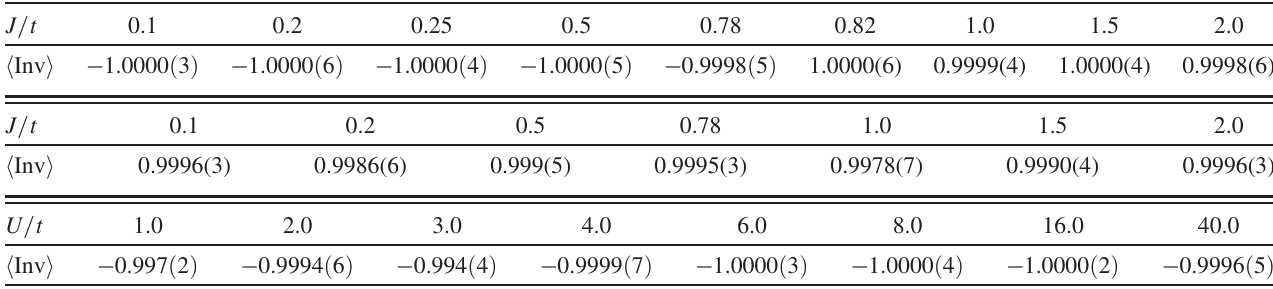
TABLE IV. Expectation value of inversion operator in DMRG ground state. Top: t - J model on the 32-site sample; middle: t - J model on the 24-site sample; bottom: Hubbard model on 32-site sample.